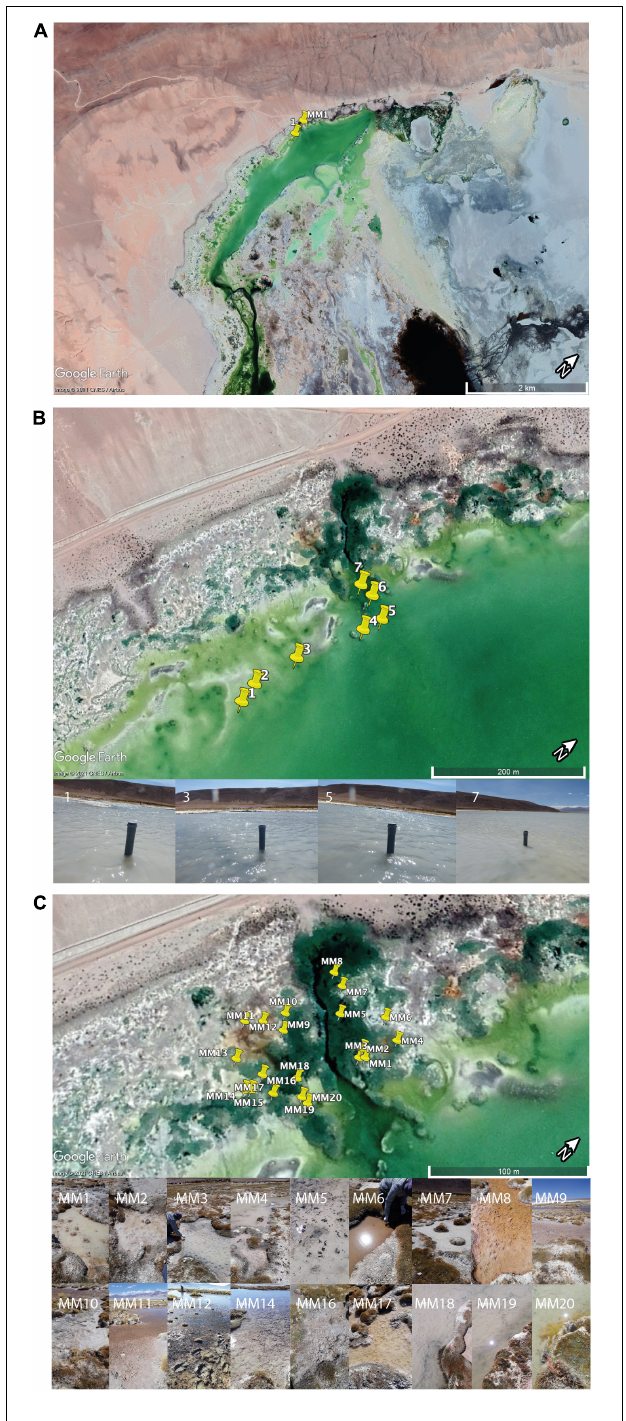
FIGURE 1 | Sampling area. (A) An overview of the sampling area indicating the region in which samples for this study were collected. The sampling area was selected based on a previous study (Dorador et al., 2008b) that showed a significant salinity gradient and a large diversity of microbial mats in a limited geographical area. (B) Close-up of the area of sampling within the saline lake showing the location of the seven sediment cores. (C) Close-up of the area of sampling within ponds containing microbial mats. The images of the 18 ponds are presented to illustrate the diversity of mats